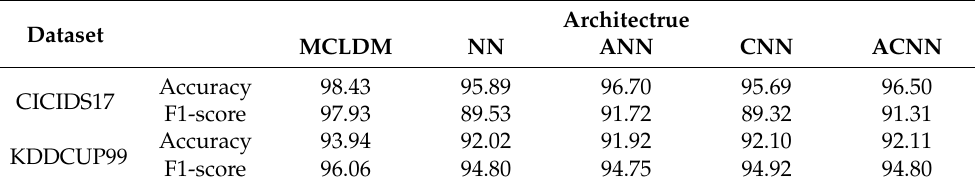
Table 5. Accuracy and F1-score of MCLDM, NN, ANN, CNN, ACNN architecture validated in datasets CICIDS17 and KDDCUP99.